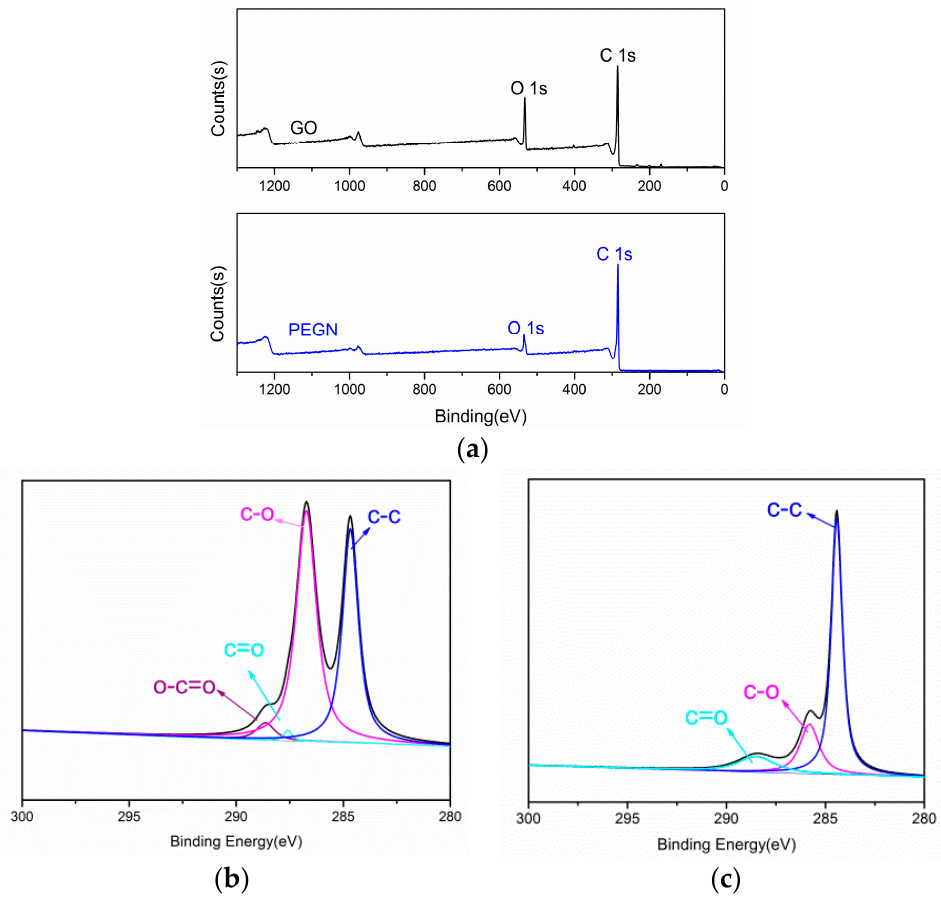
Figure 6. XPS spectra of GO and PEGN. ( a ) Survey scan of GO and PEGN. High-resolution C1s spectra of ( b ) GO and ( c ) PEGN.